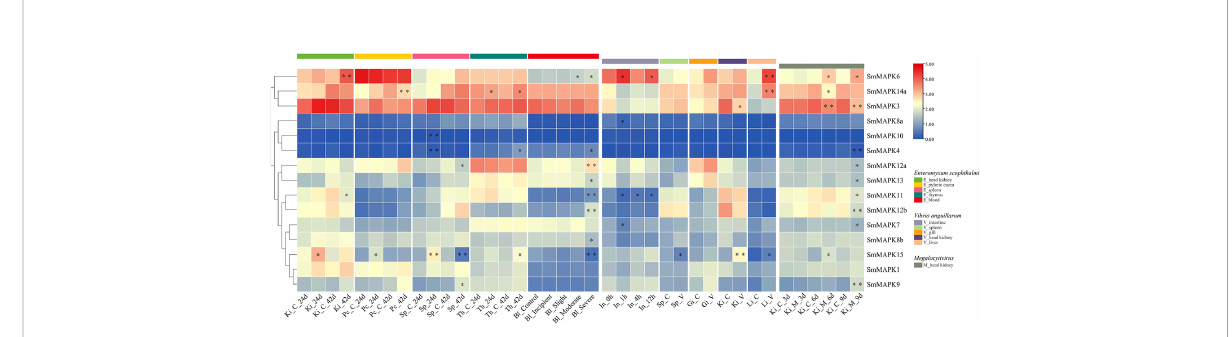
FIGURE 6 Heat map of mitogen-activated protein kinases (MAPK) expression in Scophthalmus maximus under pathogen ( Enteromyxum scophthalmi , Vibrio anguillarum , and Megalocytivirus ) infection. Ki, Pc, Sp, Th, Bl, In, Gi, and Li represent the head kidney, pyloric caeca, spleen, thymus, blood, intestine, gill, and liver, respectively. C represents the control group, V represents the V. anguillarum infection, and M represents the Megalocytivirus infection. Each cell with a different color corresponds to a different expression level, which was normalized into log 2 (FPKM + 1). *Signi fi cantly differentially expressed of MAPK genes with P < 0.05. **Extremely signi fi cant differential expression of MAPK genes with false discovery rate (FDR) < 0.01 and |log 2 fold change (FC)| >